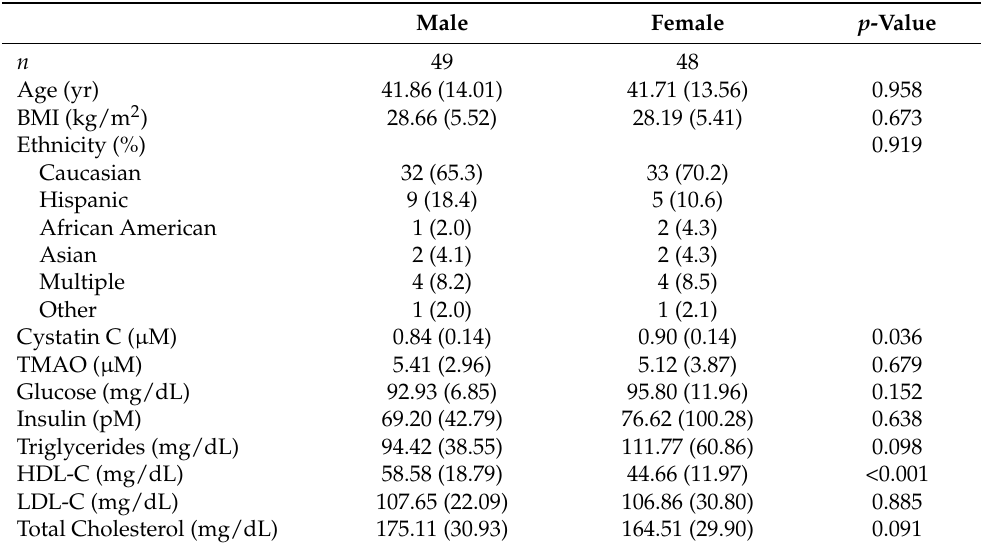
Table 1. Descriptive statistics of the participants by sex. Blood parameters were measured in the fasting state.